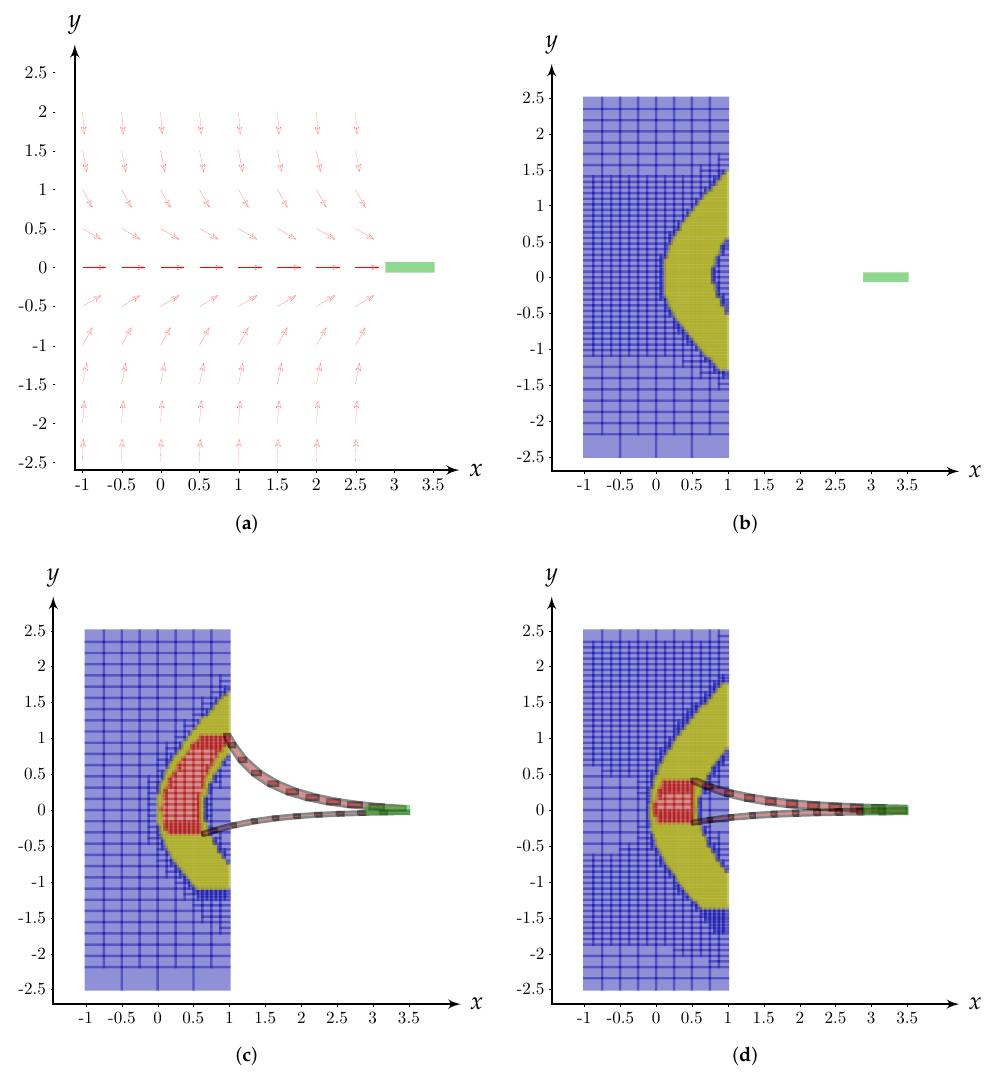
Figure 12. Vector field and results of Algorithm 4 for different controllers. ( a ) red: vector field ˙ x = f ( x ) , green: [ d ] . ( b ) k px = k py = 1, blue: D − , yellow: B , green: [ d ] . ( c ) k px = k py = 2, blue: D − , yellow: B , red: D + and extreme trajectories, green: [ d ] . ( d ) k px = k py = 5, blue: D − , yellow: B , red: D + and extreme trajectories, green: [ d ]